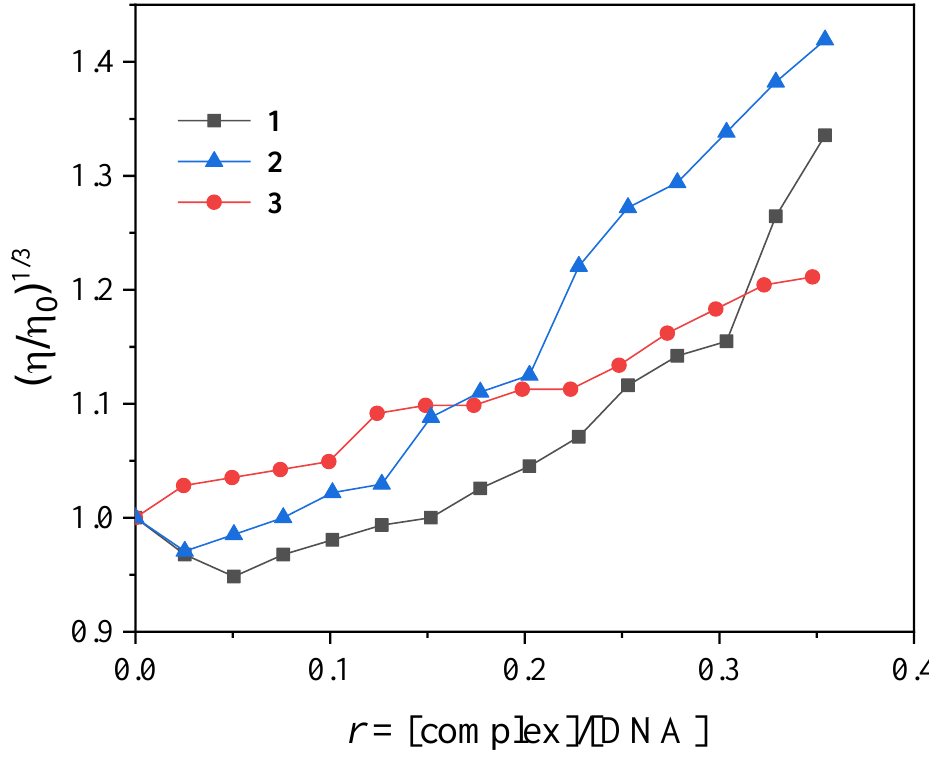
Figure 8. Relative viscosity of CT DNA ( η / η o ) 1/3 in buffer solution (150-mM NaCl and 15-mM trisodium citrate at pH 7.0) in the presence of complexes 1 – 3 at increasing amounts ( r = [complex]/[DNA]).